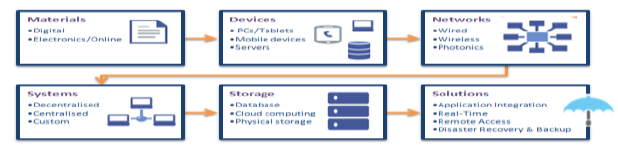
Figure 2: Components of Corporate